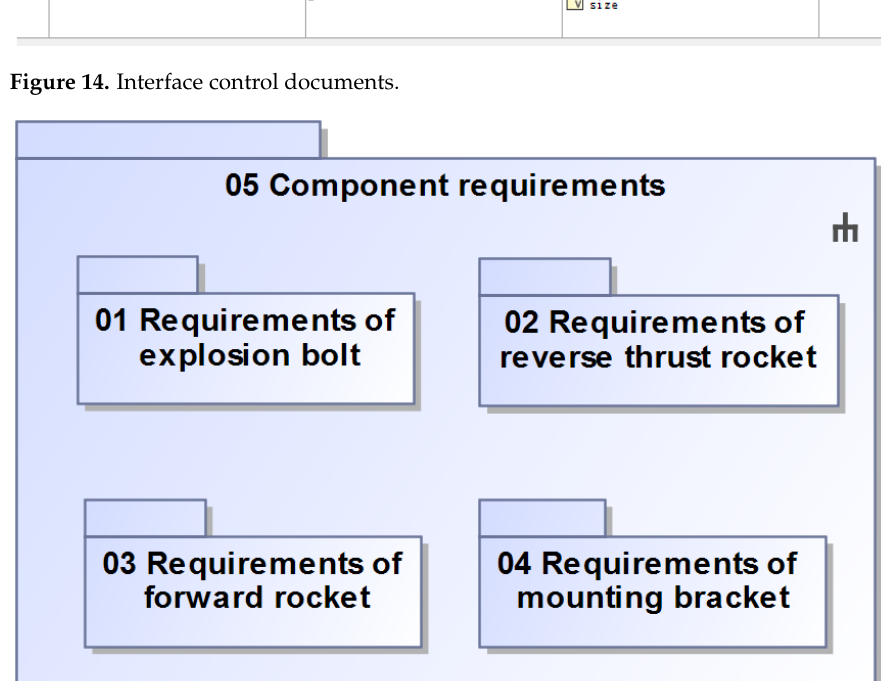
Figure 15. Component requirements.